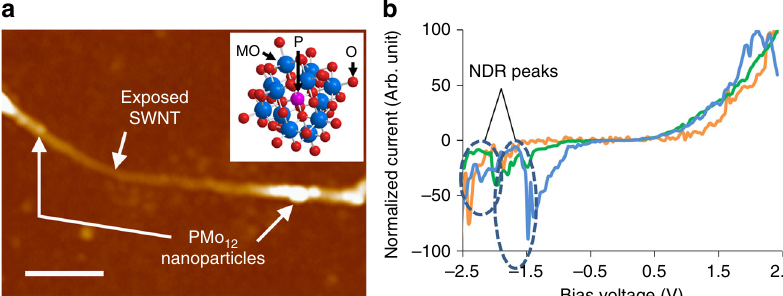
Fig. 1 SWNTs complexed with POM. a AFM image of the SWNT/POM complex. (Inset) Molecular structure of PMo 12 , reproduced from its reported X-ray crystallographic structure (scale bar = 200 nm). b I – V characteristics of the SWNT/POM complex, measured by PCI-AFM, where several